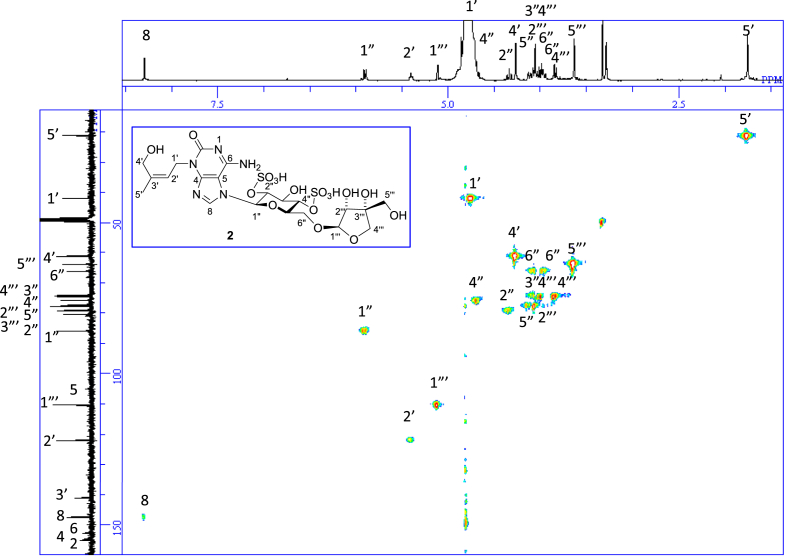
1H–13C HSQC of 2.